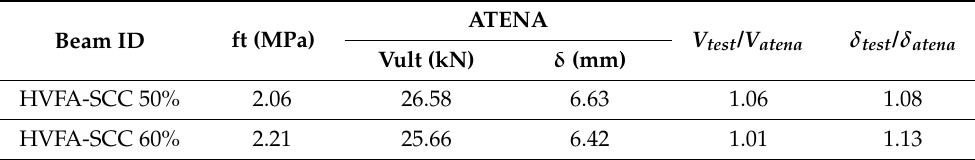
Table 6. Comparison of measured and predicted shear strength and deflection.